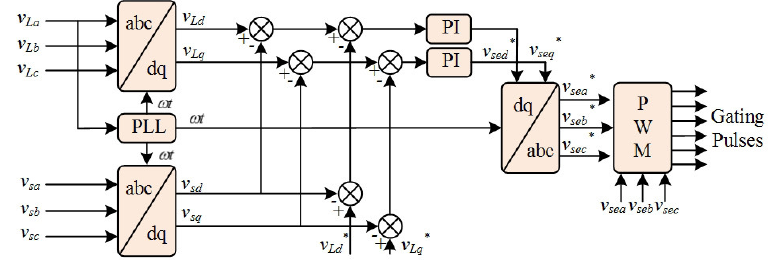
Figure 2. Control loop of the series compensator.